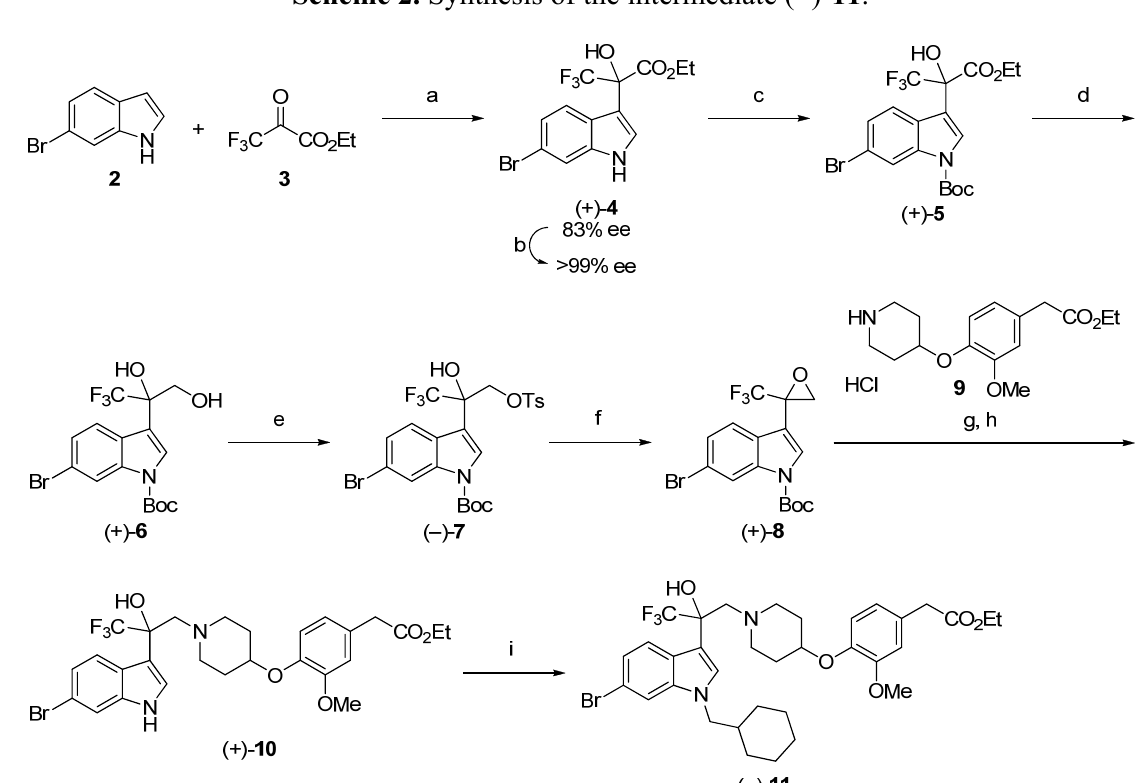
Scheme 2. Synthesis of the intermediate ( − )- 11